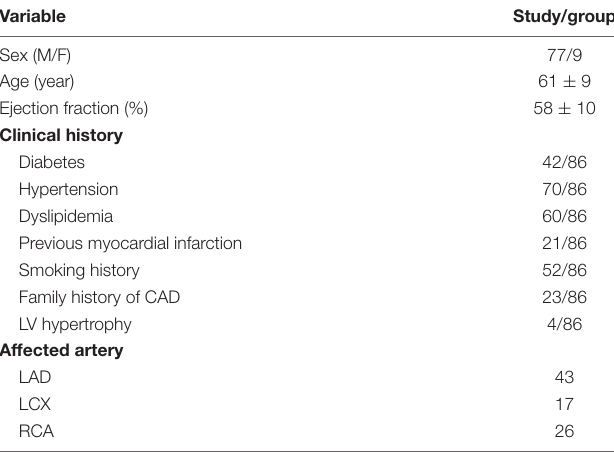
TABLE 1 | Summary of clinical data and characteristics of the 86 recruited